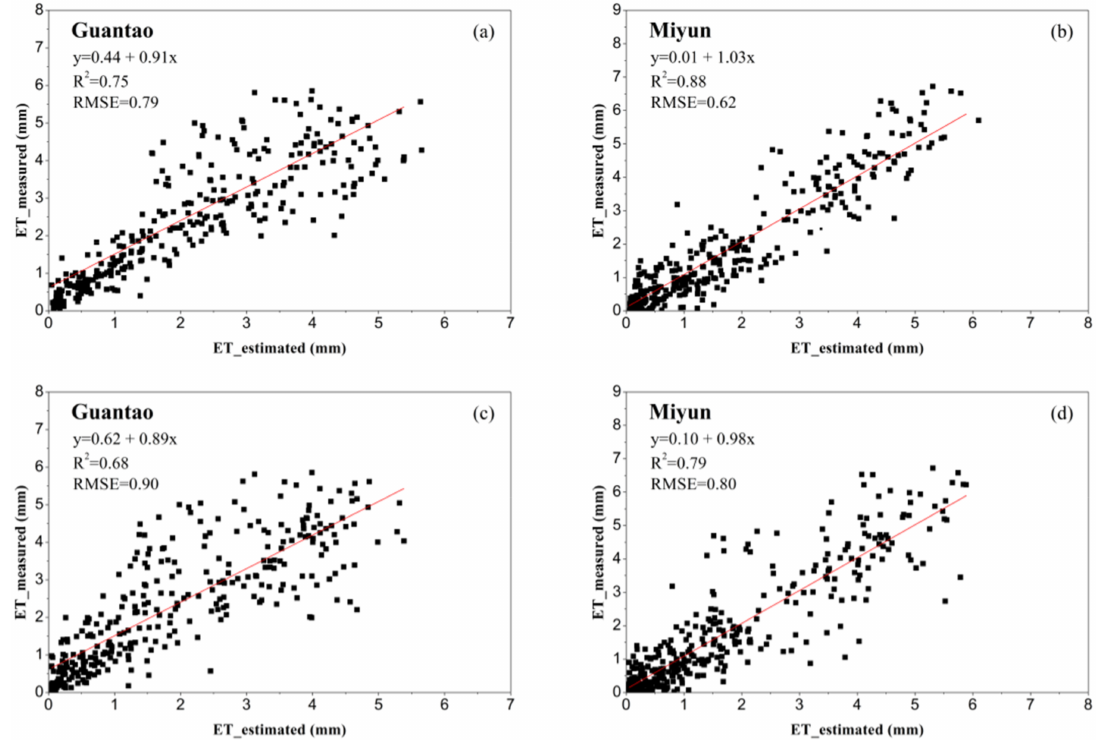
Figure 5. Daily ET comparisons between estimations and EC measurements. ( a ) Estimation with enhanced method at GT site; ( b ) estimation with enhanced method at MY site; ( c ) estimation with original method in GT site; and ( d ) estimation with original method at MY site. The red line is fitting line. The black boxes indicate values of